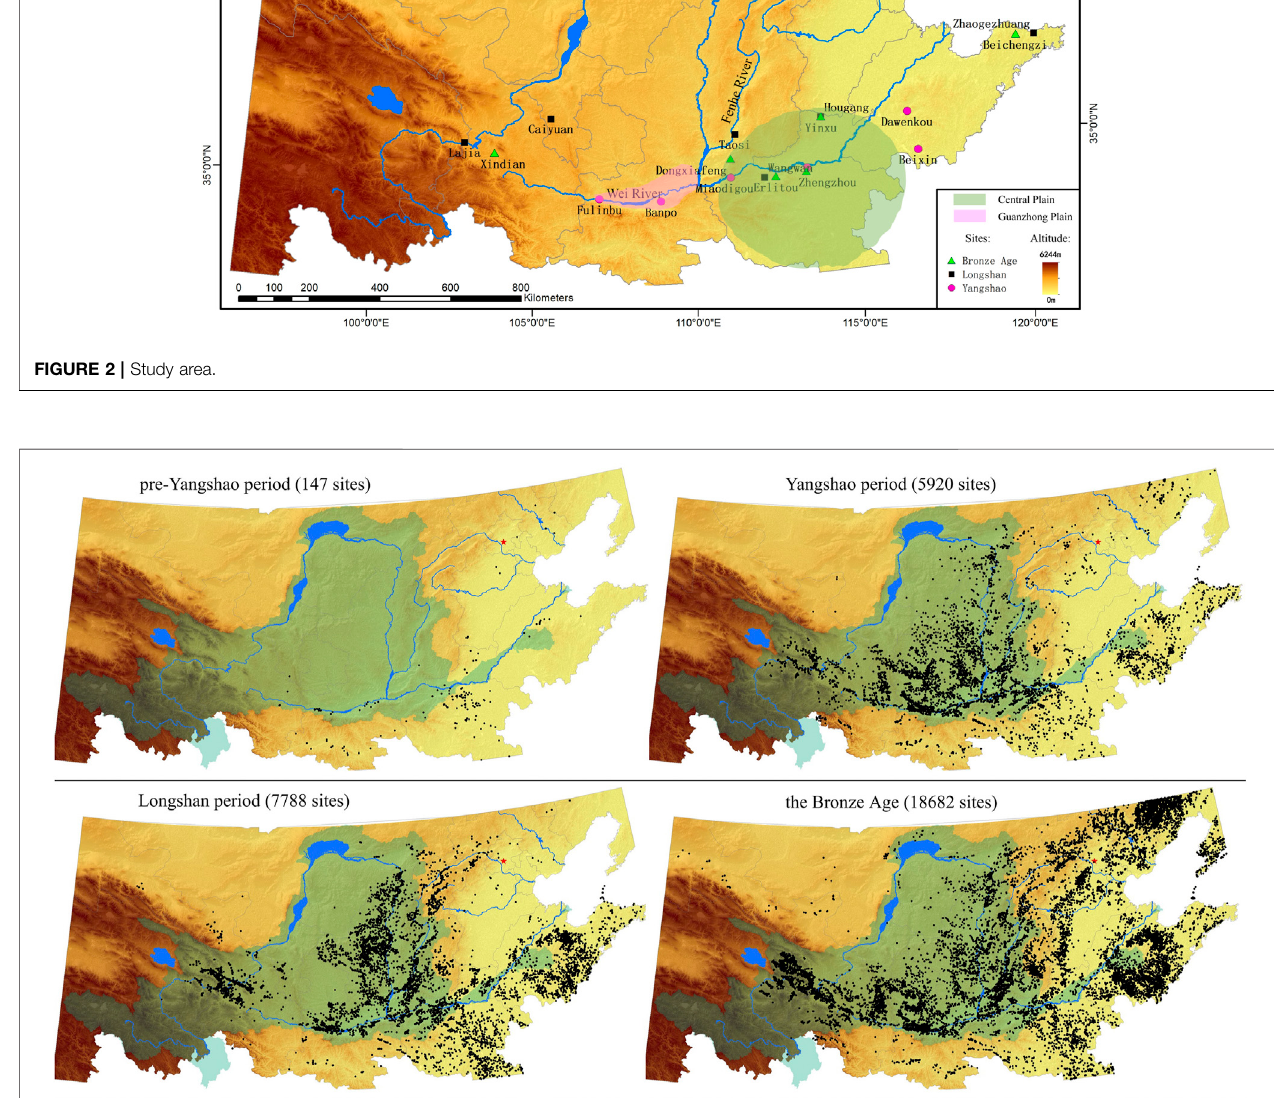
FIGURE 3 | Distribution of sites from pre-Yangshao period to the Bronze Age in the Yellow River basin and surrounding regions.